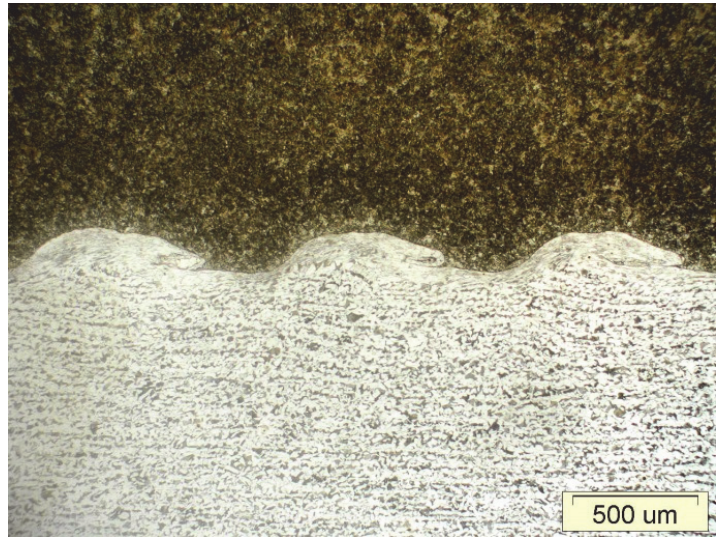
Figure 2: Interface zone location